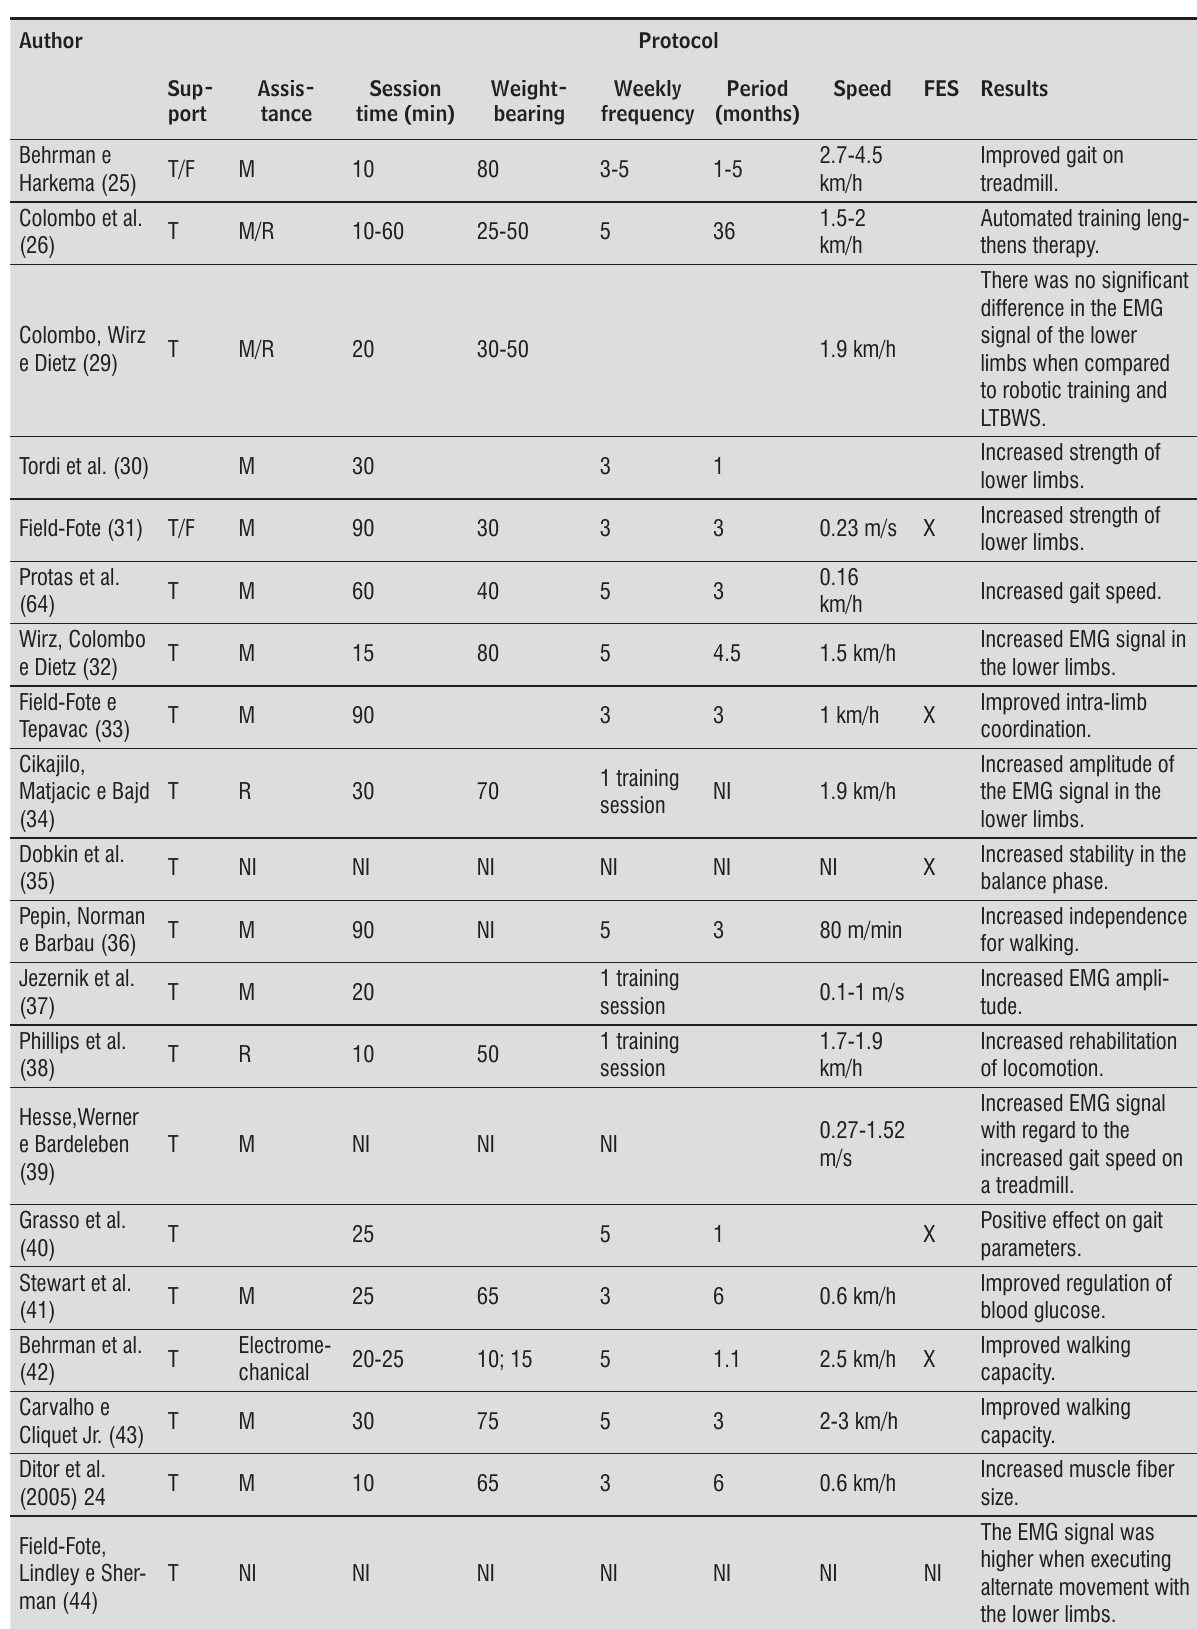
Table 2 - LTBWS protocols and their respective